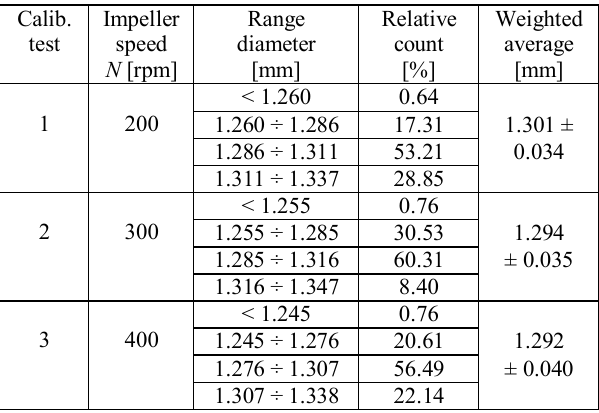
Table 4. Calibration data results for Rushton turbine Calib.